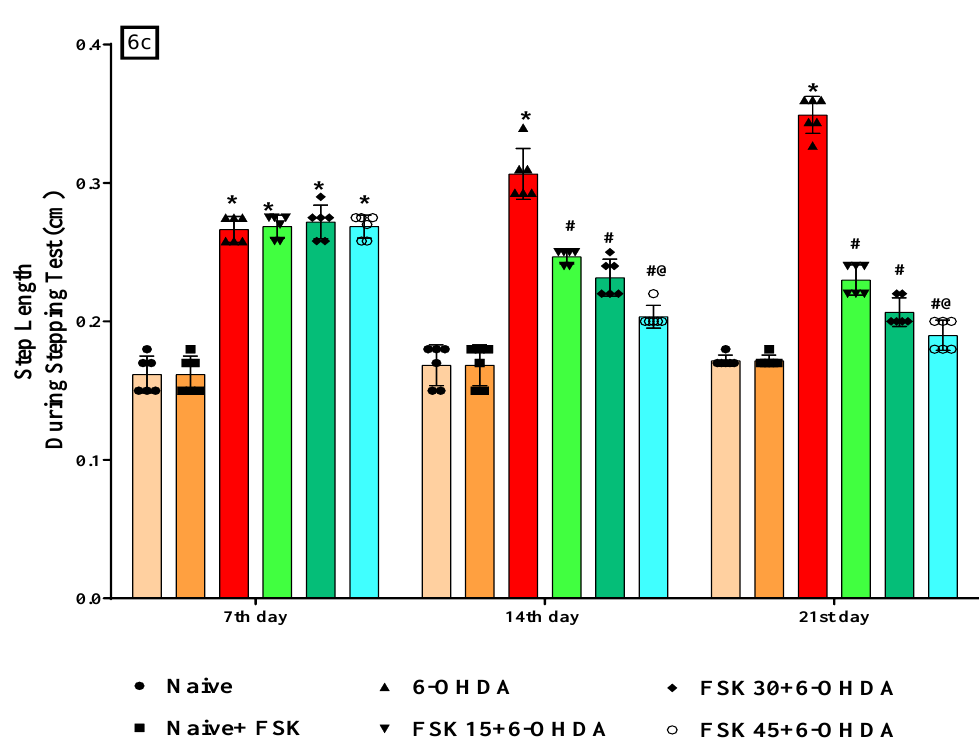
Figure 6. ( a ) FSK reduced initiation time using the stepping test in the experimental model of PD; ( b ) FSK reduced stepping time using the stepping test in the experimental model of PD; ( c ) FSK reduced step length using the stepping test in the experimental model of PD. Data provided as mean ± SD (n = 6 ) followed by ANOVA (two-way) with post-hoc Bonferroni test. * 6-OHDA ( p < 0.01) compared with naive and naive + FSK ; # FSK15, FSK30, FSK45 (p < 0.01 ) compared with 6-OHDA ; #@ FSK45 (p < 0.01) compared with FSK30, FSK15 .